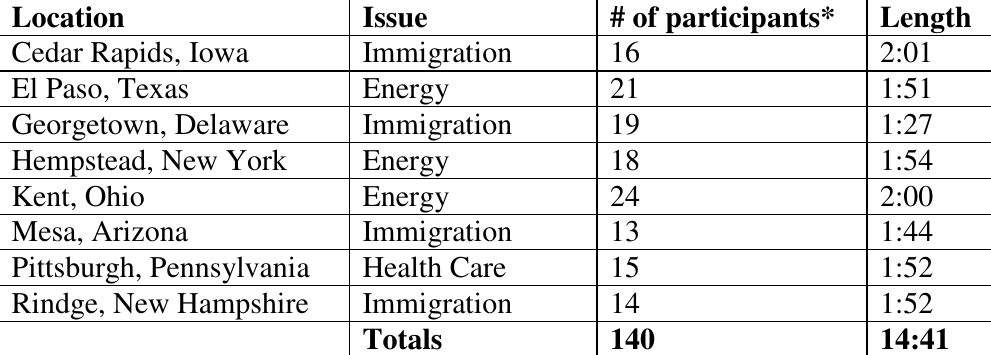
Table 1: Overview of